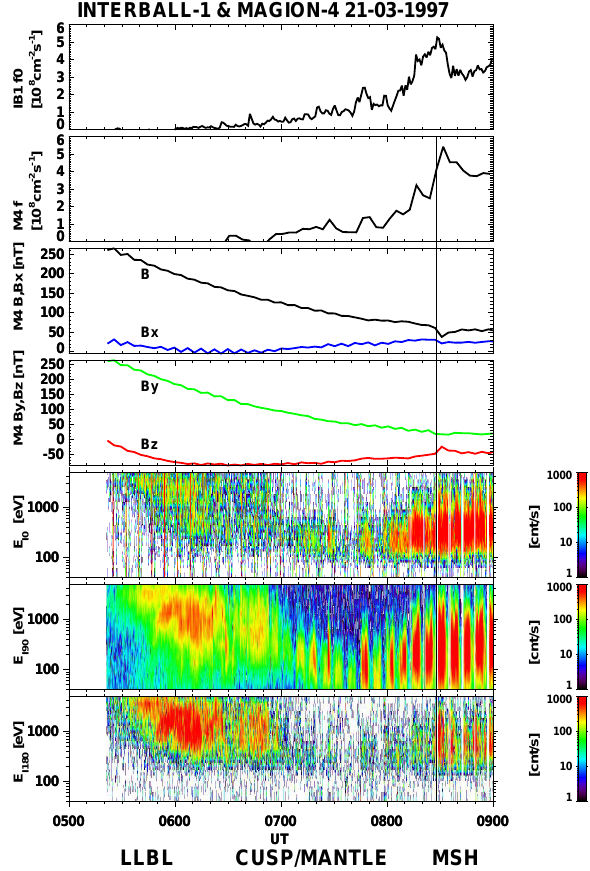
Fig. 2. MAGION-4 observations of the precipitating ions. The first panel shows the INTERBALL-1 ion flux for the sake of reference. The second panel presents the MAGION-4 ion flux and the next three panels depict ion energy spectra measured in three directions. The magnetopause crossing is distinguished by a vertical line, the identification of crossed regions is labeled in the bottom